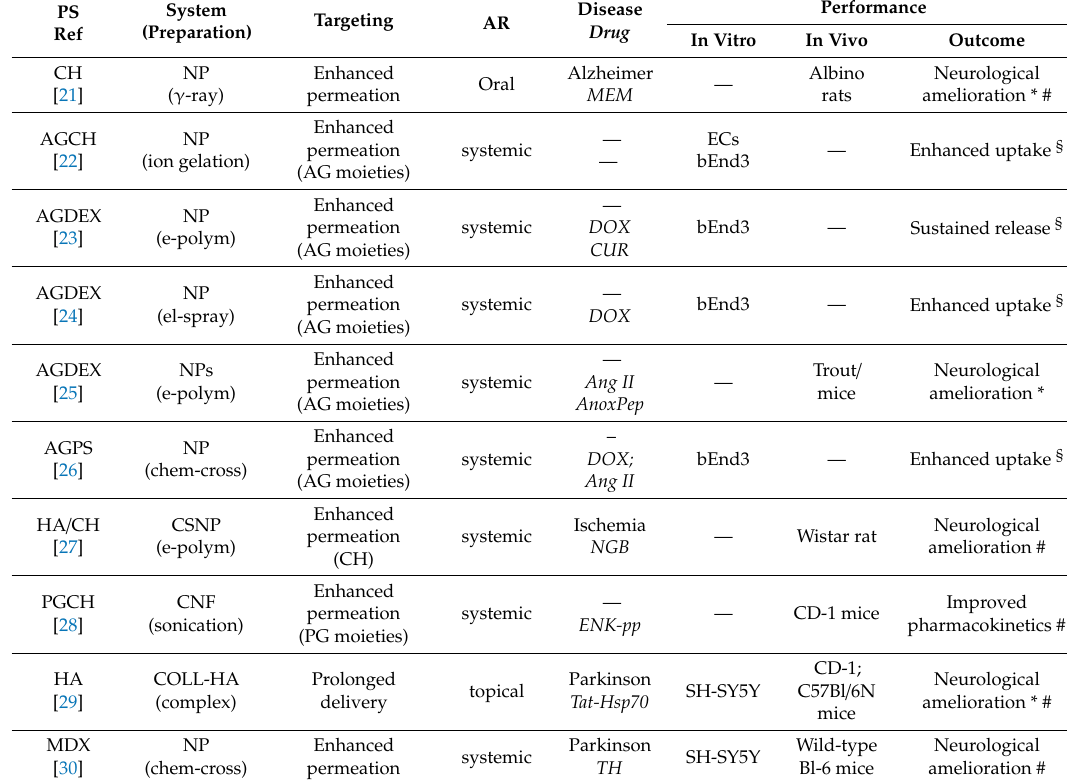
Table 1. Polysaccharide carriers for the treatment of brain diseases by passive and active targeting.